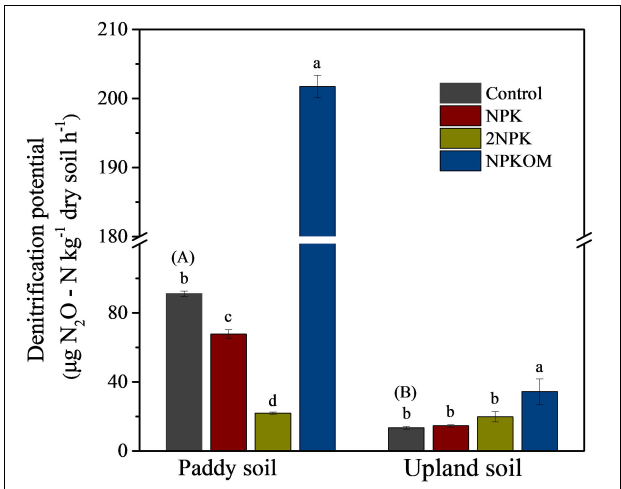
FIGURE 1 | Soil denitrification potential among different fertilization regimes in the paddy soil and upland soil. Different uppercase letters in brackets indicate significant differences for the treatment of control between paddy soil and upland soil by independent-sample t test, and different lowercase letters indicate significant differences among fertilizer treatments for each soil type ( P < 0.05, Duncan multiple-range test).